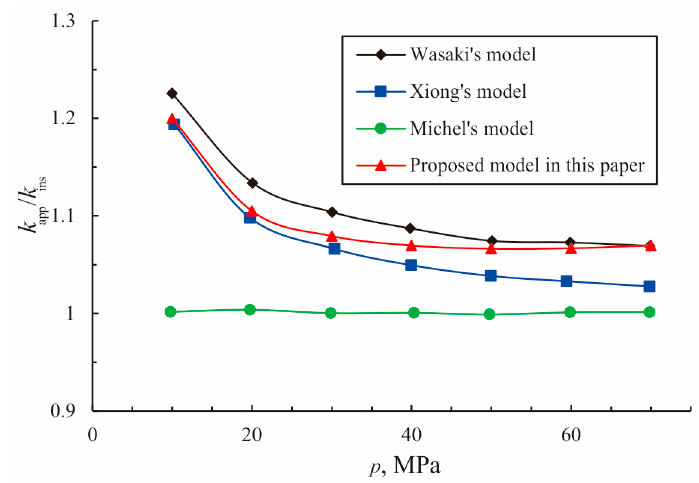
Figure 8. Comparison of our model with previous studies. Table 5. Parameters used for model comparison.